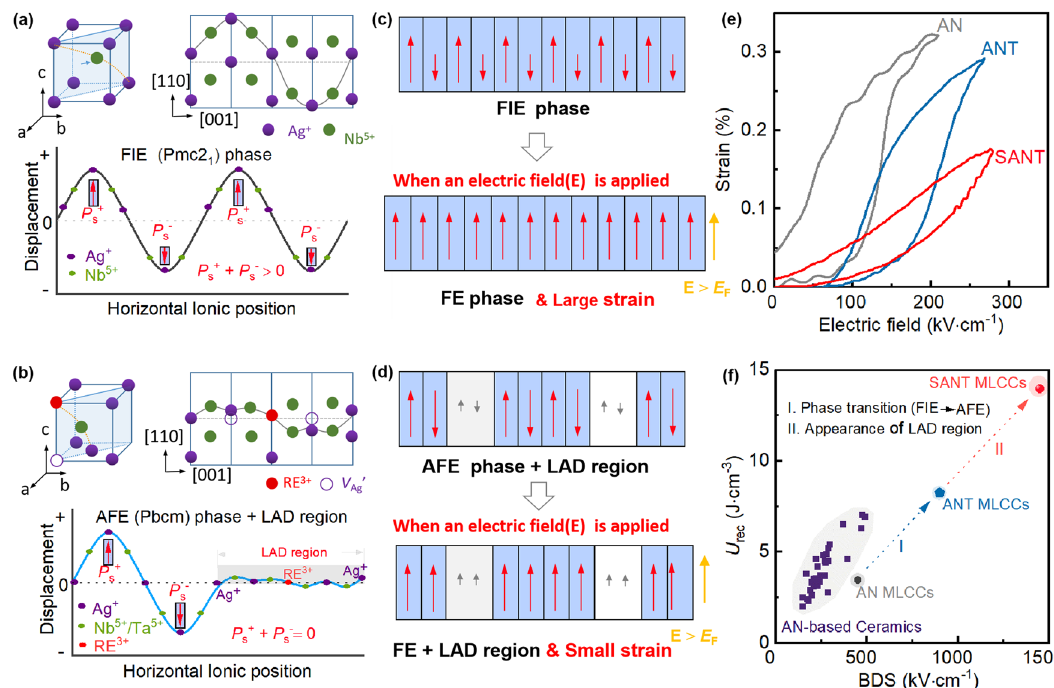
Fig. 1 | Methods for improving the BDS and energy storage performances. The crystal structure of pure AN corresponds to the ferroelectric Pmc2 1 phase, with cations showing displacements along the direction, forming a periodic variation alongthe c -axisdirection( a ).Thecrystalstructurefor(RE x Ag 1 – 3 x )(Nb,Ta)O 3 system, wheretheperiodicvariationofatom-displacement fl uctuationinAFEPbcmphaseis destroyed by the heterovalent rare earth ion RE 3+ ions, forming some low-atom-